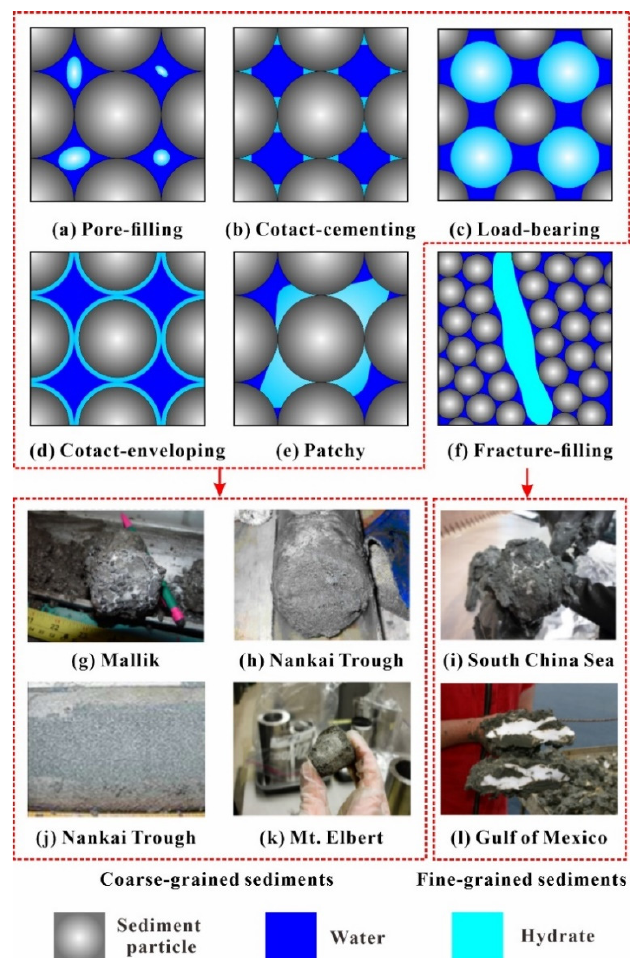
Figure 1. Hydrate morphologies in coarse-grained sediment: ( a ) pore-filling morphology, ( b ) contact cementing morphology, ( c ) load-bearing morphology, ( d ) envelope cementing morphology, and ( e ) patchy morphology, and fine-grained sediments: ( f ) fracture-filling morphology. ( g – l ) show the field hydrate morphologies in the coarse-grained and fine-grained sediments in the Mallik, Nankai Trough, the South China Sea, Gulf of Mexico, and Mt. Elbert [43]. The blue indicates water, grey indicates sand or clay grains, and light blue indicates